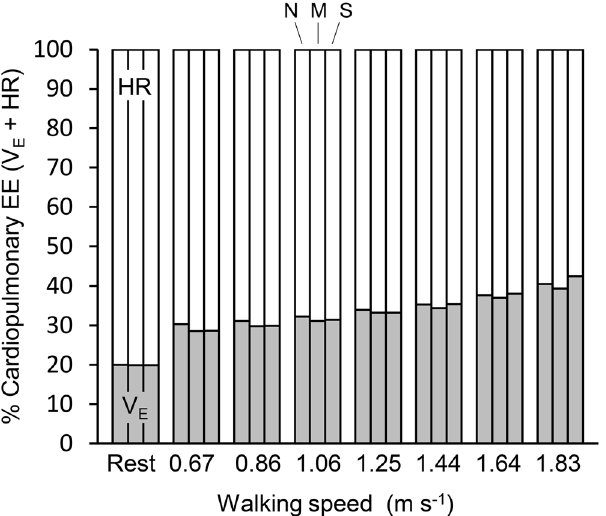
Figure 4. Contribution of V (gray segments) and HR (white segments) to cardiopulmonary energy E expenditure at rest and at each walking speed under normoxia (N), moderate hypoxia (M), and severe hypoxia (S)